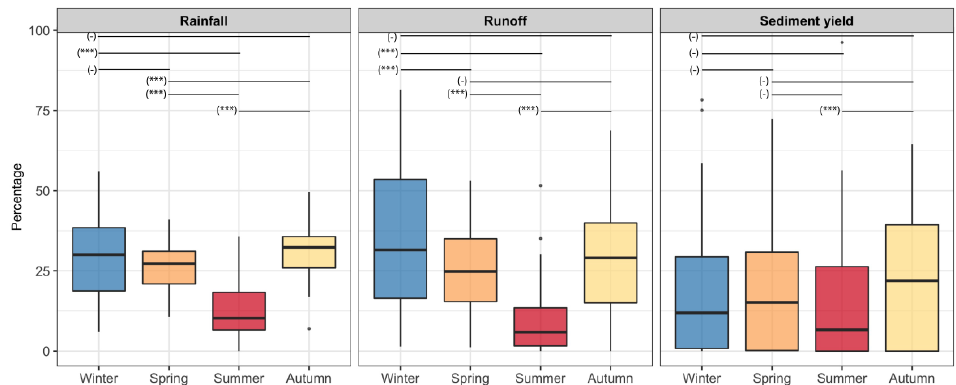
Figure 1. Seasonal distribution of the percentage of rainfall, runoff, and sediment yield. The ends of the box are the upper and lower quartiles, so the box spans the interquartile range, the median is marked by a vertical line inside the box, and the whiskers are the two lines outside the box that extend to the highest and lowest observations. The significant value at p < 0.05 (***) and not significance (-) of Wilcoxon signed-rank test are paired remarked between winter and spring, winter and summer, winter and autumn, spring and summer, spring and autumn, and summer and autumn. Figure 2 shows the spatial distribution of the seasonal percentages of rainfall, runoff, and SY, below and above 25% of annual value. Sites with >25% rainfall in winter, spring and autumn show a fairly homogeneous spatial distribution, while on the contrary in summer, high rainfall contribution values are only reached in the northeastern inland region. Runoff follows a similar pattern in sites with >25% contribution in winter, spring and autumn, while in summer high values are only reached in the eastern area. Last, SY distribution shows less spatial coherence and high seasonal spatial variability: winter and spring show a fairly homogeneous spatial distribution, while for summer and autumn sites with >25% are mostly located in the eastern area.